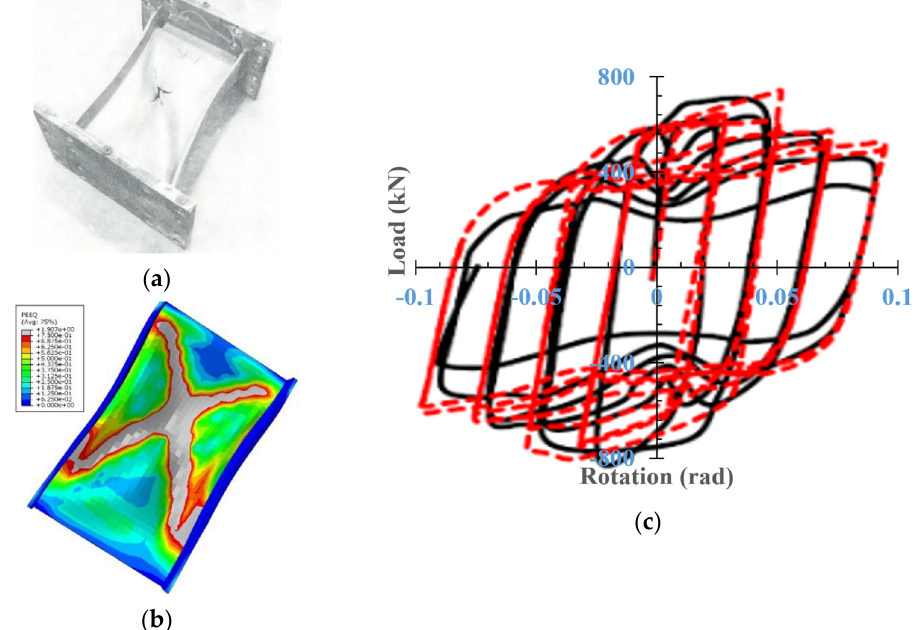
Figure 3. Comparison of results of the FE modeling and the experimental test. ( a ) The shear link at the end of testing [35]; ( b ) FE simulation; ( c ) comparing the hysteresis curves.